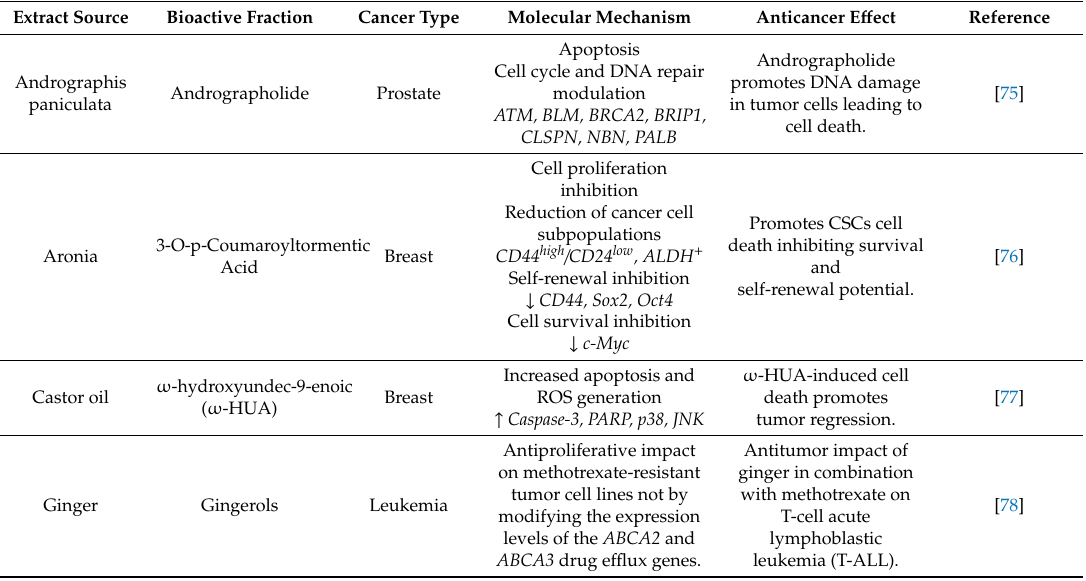
Table 3. Characteristics of included studies related to bioactive natural